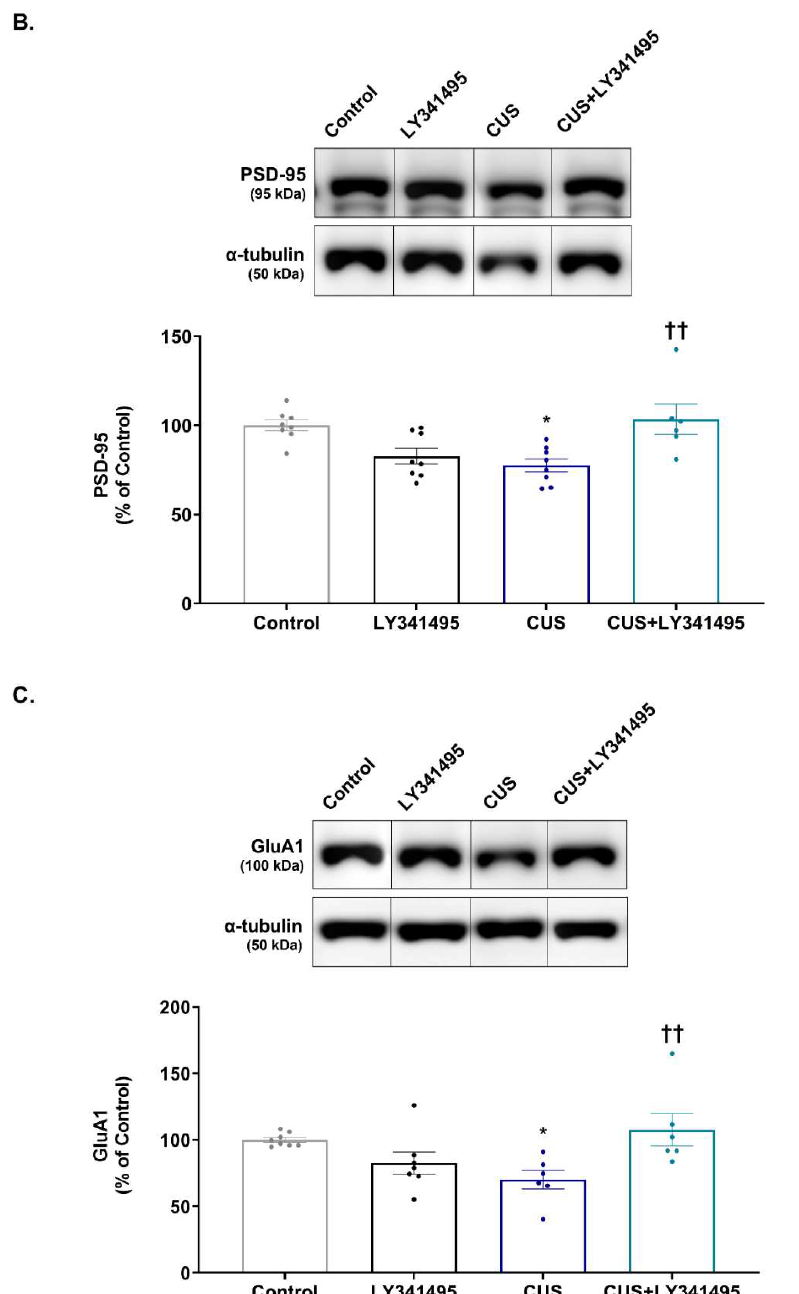
Figure 3. Effects of chronic LY341495 administration on protein kinase B (Akt) phosphorylation and postsynaptic density-95 (PSD-95) and AMPA receptor subunit GluR1 (GluA1) hippocampal expres- sion in chronic unpredictable stress (CUS)-exposed mice. Mice were treated daily with LY341495 (1 mg/kg) or vehicle (1 mL/kg, 0.9% saline) with (the CUS and CUS + LY341495 groups) or without (the control and LY341495 groups) CUS for 4 weeks. The hippocampal levels of phospho-Akt ( A ), PSD-95 ( B ), and GluA1 ( C ) were determined by Western blotting. The levels of phosphorylated and synaptic proteins were normalized to the total protein and α-tubulin levels, respectively. The origi- nal images from which we constructed Figure 3 A–C are shown as supplementary materials. Values represent mean ± SEM expressed as percentages of those of the control group; * p < 0.05 vs. the control group; † p < 0.05 vs. the CUS group, †† p < 0.01 vs. the CUS group.